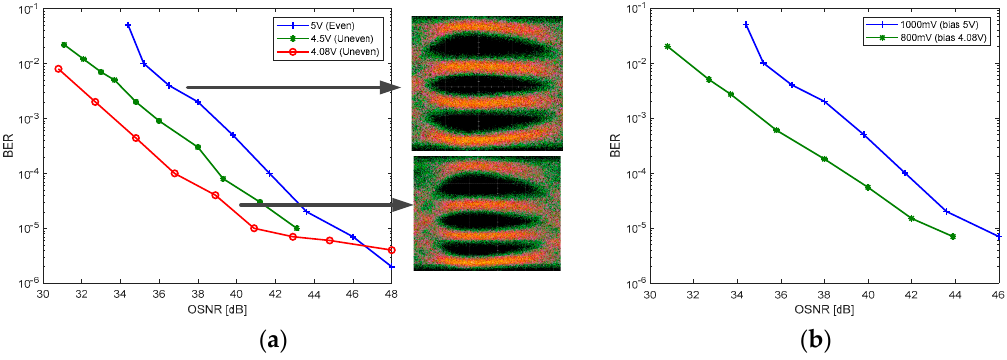
Figure 4. BER vs. OSNR: ( a ) BER vs. OSNR for different MZM bias values. ( b ) Even power levels spacing at bias of 5 V, (blue curve ‘+’) compared to uneven power levels spacing with bias of 4.08 V, (green curve ‘*’), while keeping identical OMAouter using 1000 mV and 800 mV MZM input voltage swing.